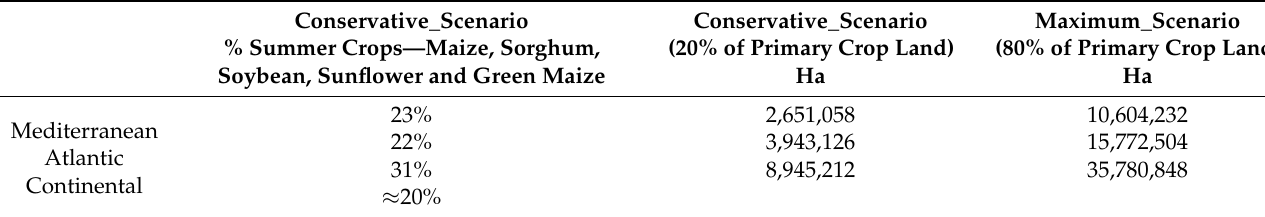
Table 3. Percentages of land dedicated to sequential cropping in Conservative_Scenario and Maximum_Scenario and corre- sponding hectares.